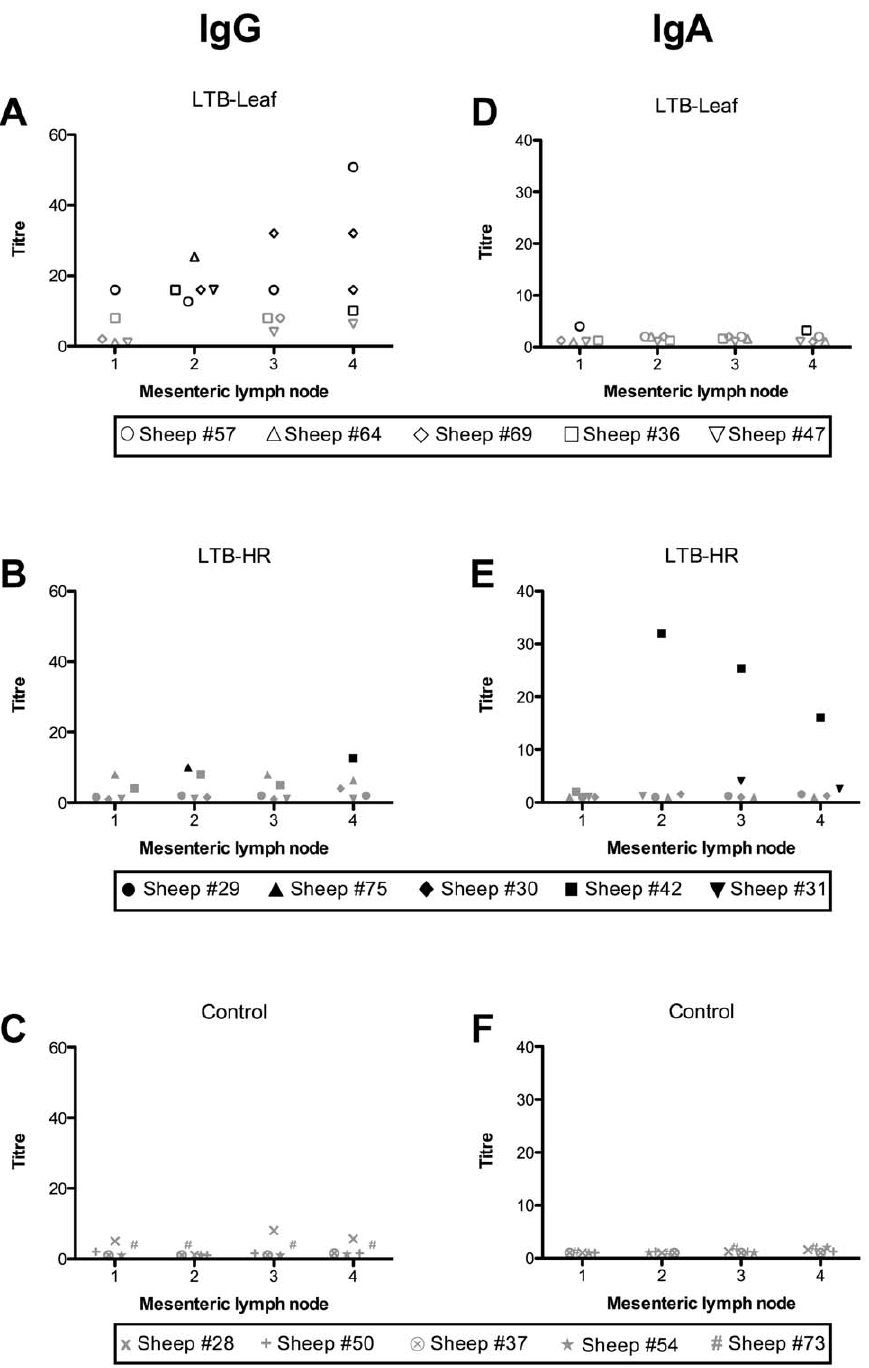
Figure 2. LTB-specific antibody titres in MLNs collected from successive sites along the small intestine of the sheep GIT following oral immunisation with four doses of LTB-Leaf (A and D, IgG and IgA respectively), LTB-HR (B and E, IgG and IgA respectively) or control (C and F, IgG and IgA respectively) plant materials. MLN 1 was sampled from the abomasum/duodenum junction, MLN 2–4 were the next three lymph nodes sampled from the first 0.5 m of the small intestine. Black symbols denote positive responders defined as sheep with antibody titres at least three standard deviations above the control mean, non-responders are indicated by grey symbols. doi:10.1371/journal.pone.0052907.g002 standard. Accumulation of the functional pentameric form of rLTB was confirmed by western blot [3].